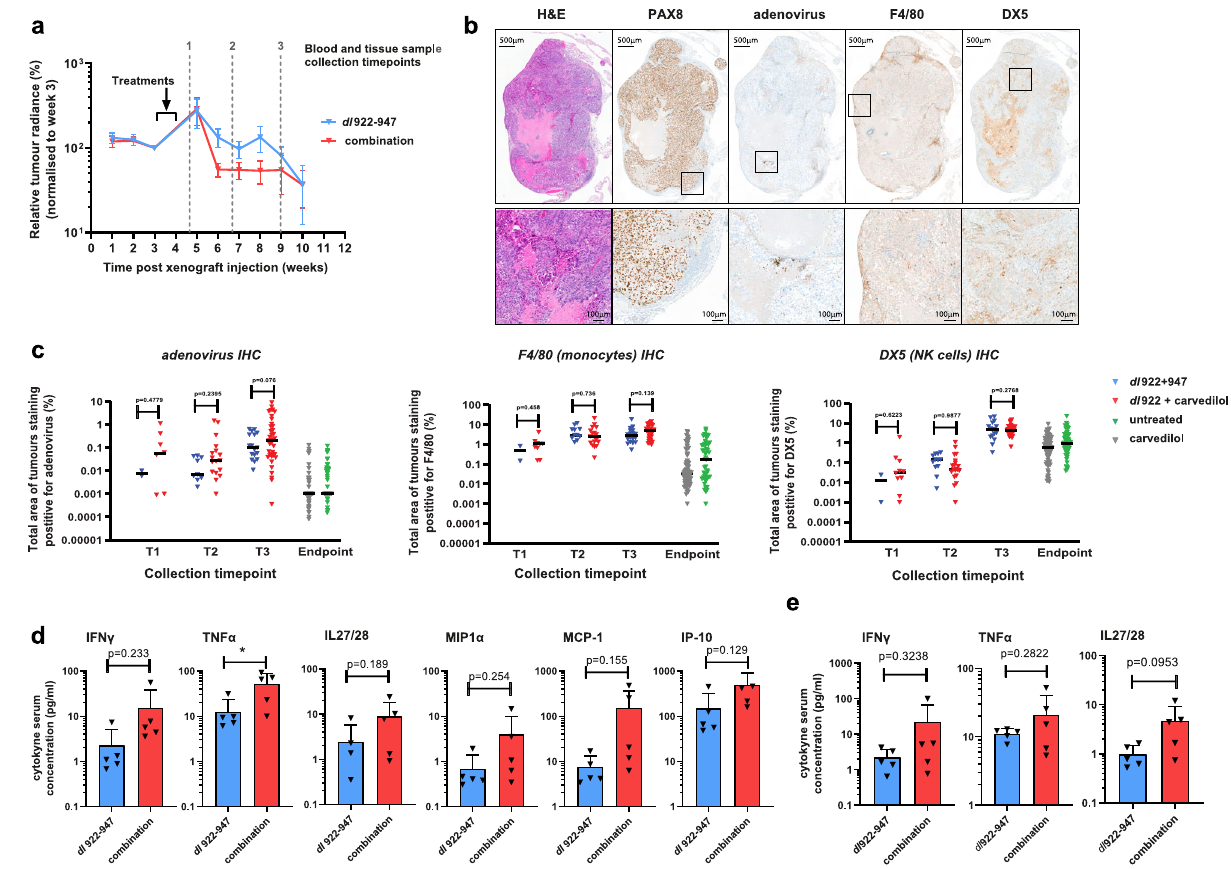
Fig. 6 Co-treatment with virus and carvedilol induces innate immunity in vivo. a Inset of radiance data (shown with individual data points in Fig. 5e) to indicate experimental plan and time points for collection of blood and tissue samples in remainder of this fi gure. b Representative histology images of (top) tumour samples stained for H&E, PAX8, adenovirus, F4/80 and DX5 (scale bar: 500 μ m), (low) magni fi ed area denoted by the box above (all images are from a single mouse treated with the combination of dl 922-947 and carvedilol and culled at time point 3; scale bar: 100 μ m). c Percentage of the total surface area of tumour samples staining positive for adenovirus (left panel), F4/80 (macrophages, middle panel) and DX5 (NK cells, right panel) (frequency distribution violin plot, median (black) + interquartile range (grey); n = 5 mice per group, mean 28 measurements per group). d Systemic cytokines quanti fi ed at time point 1 in mice treated with carvedilol and dl 922-947 ( n = 5 mice, mean + SD, unpaired t -test, ns P > 0.05, * P ≤ 0.05). e Systemic cytokines quanti fi ed at time point 3 in mice treated with carvedilol and dl 922-947 ( n = 5 mice, mean + SD, unpaired t -test, ns P >